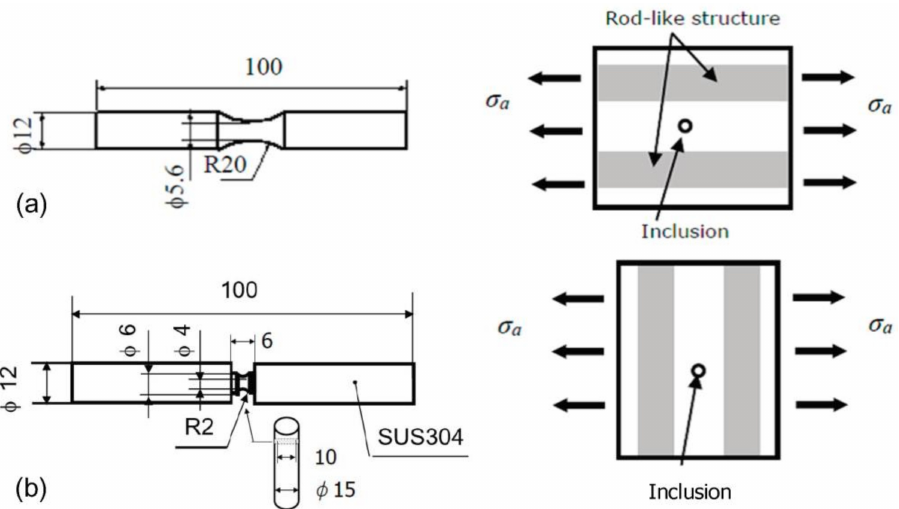
Figure 3. Shape and dimensions of fatigue specimens; relationship between σ a and rod-like structure (schematic diagram). ( a ) Specimen P; ( b ) specimen